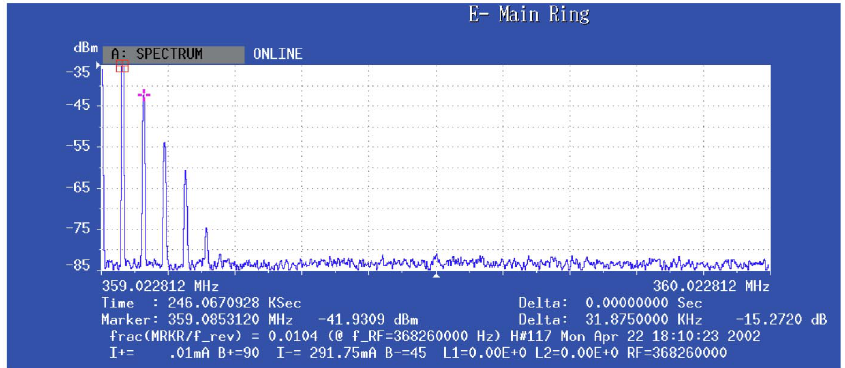
FIG. 7. (Color) Multibunch beam power spectrum at (cid:2) 300 mA with LFB off. The square marker is on the revolution harmonic; the cross marker is on the dipole oscillation right sideband.